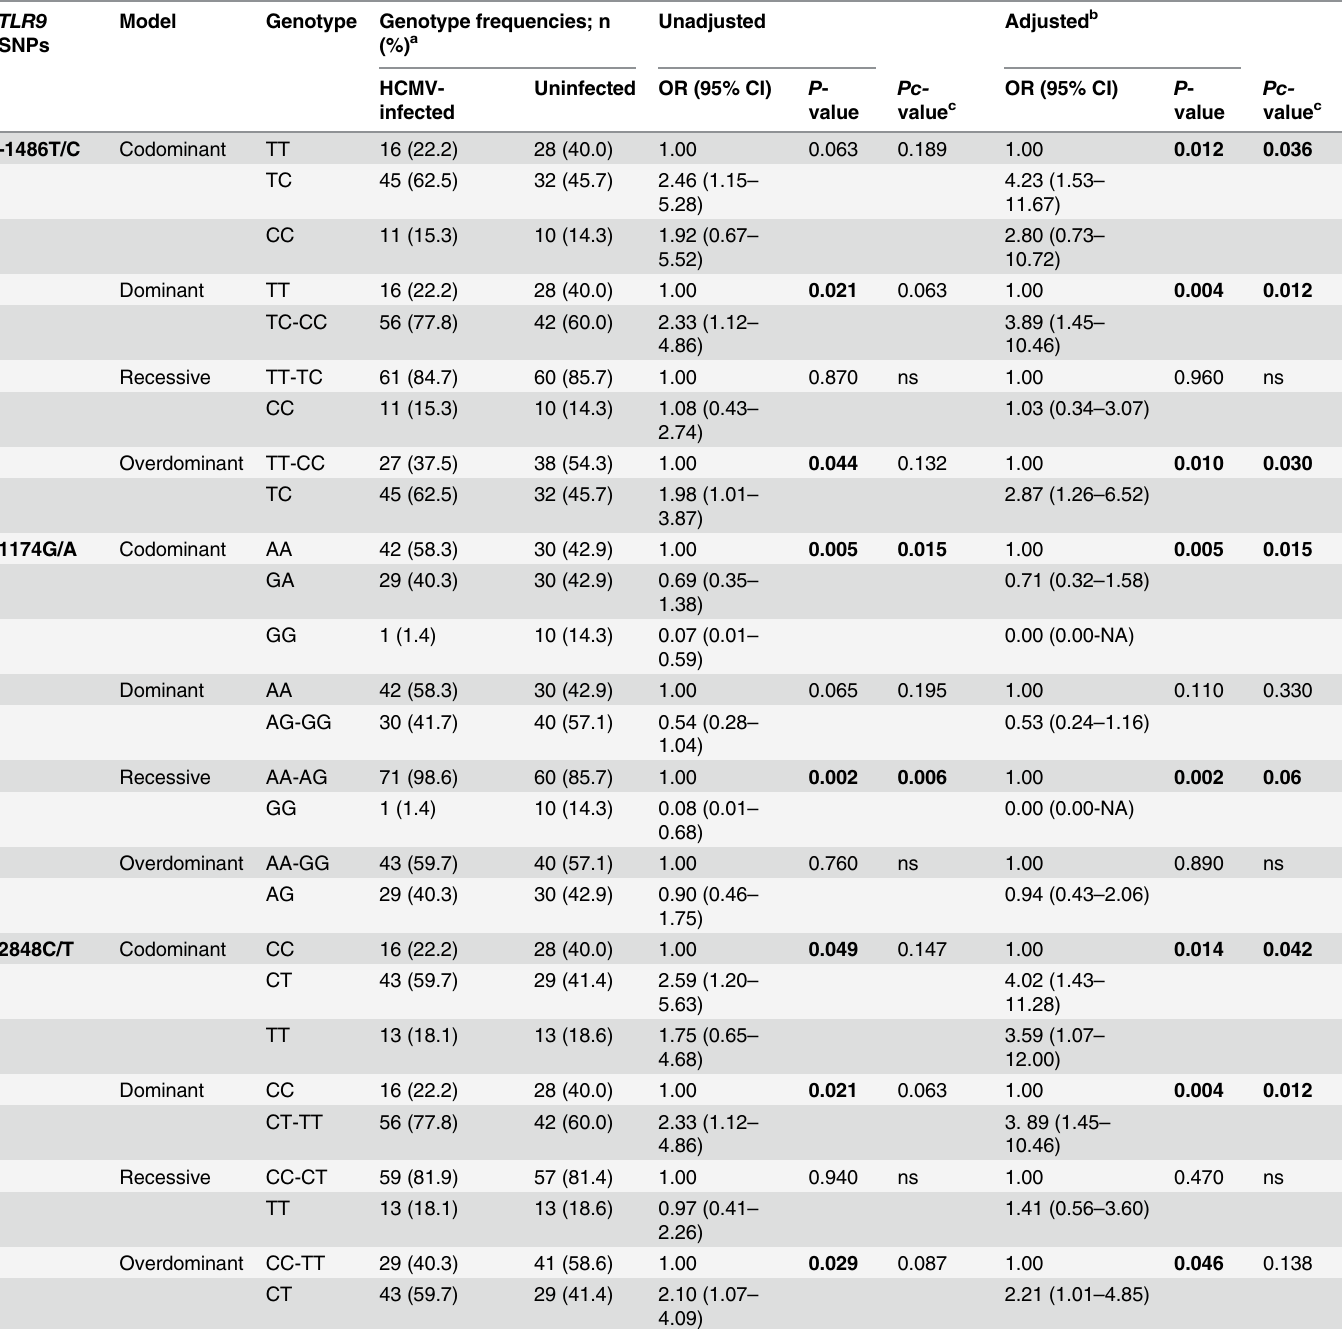
Table 3. The distribution of genotypes frequencies of TLR9 SNPs in infants and relationship between polymorphisms and the risk of HCMV infection.